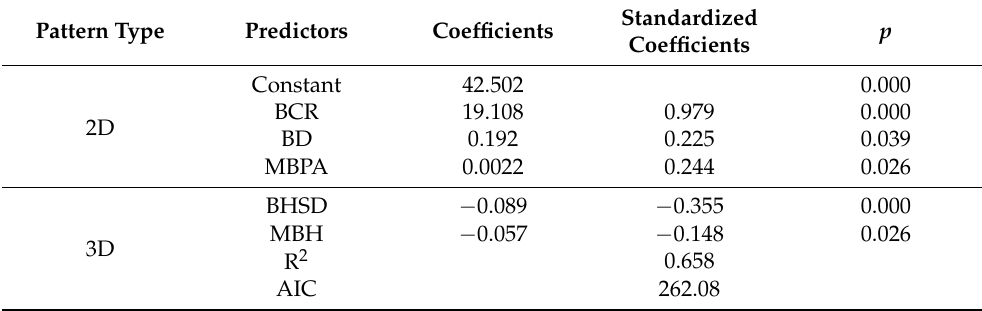
Table 3. Statistics of the OLS regression models.